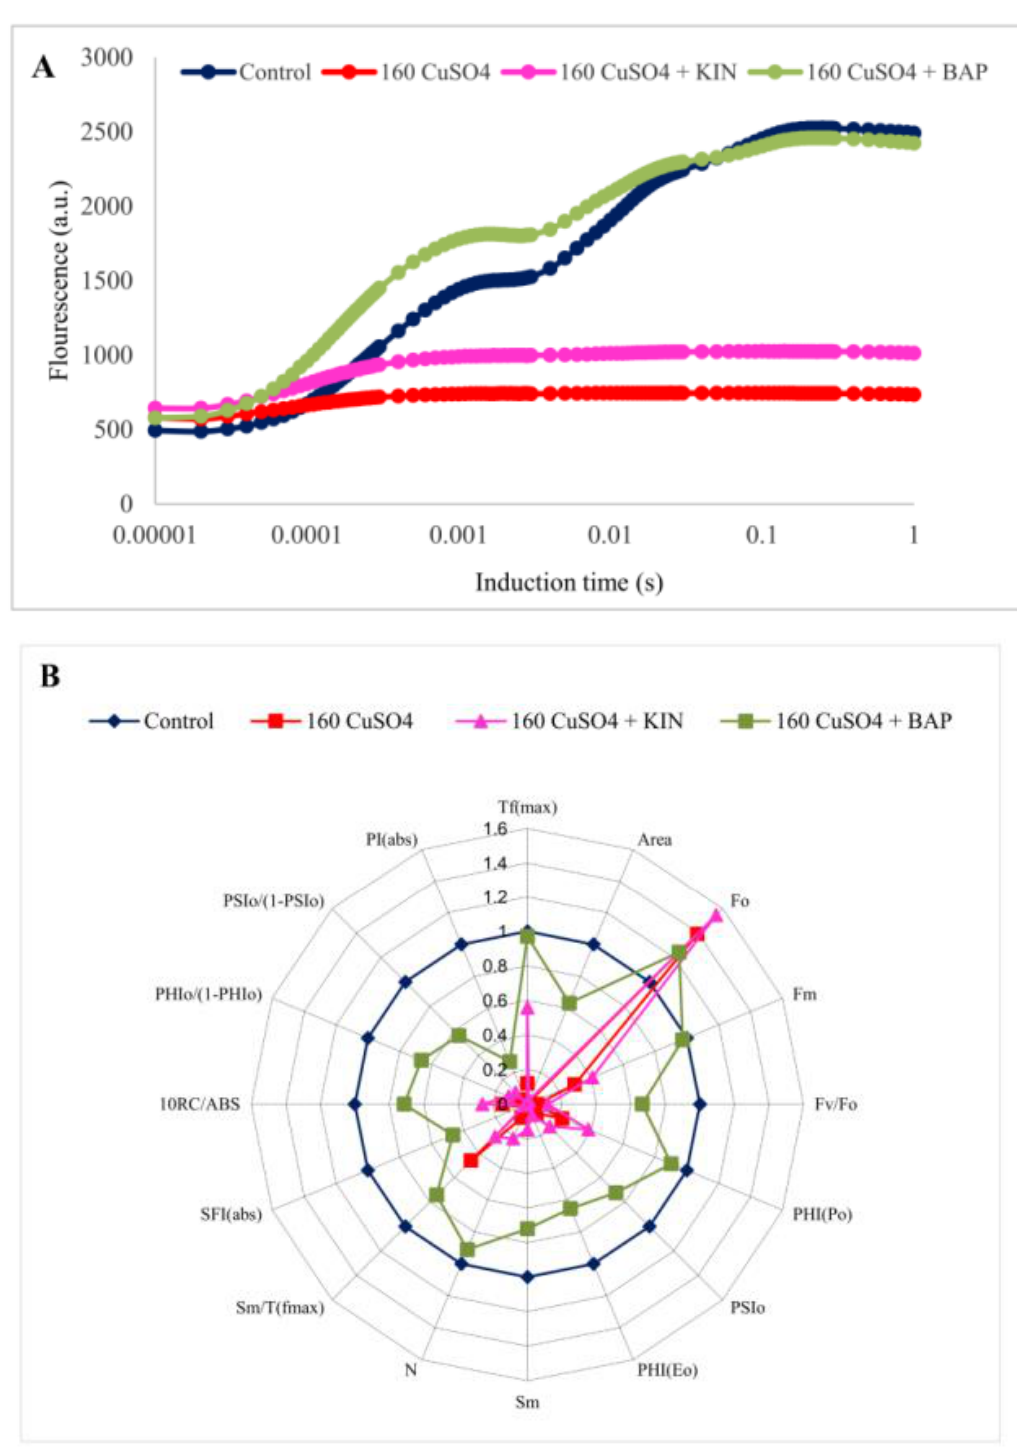
Figure 3. Fluorescence induction curve ( A ) and radar plot ( B ) in the cotyledonary leaves of R. communis for 4 day of exposure to CuSO 4 (160 μM) and cytokinin (KIN and BAP) treatments in Hoagland’s nutrient medium.